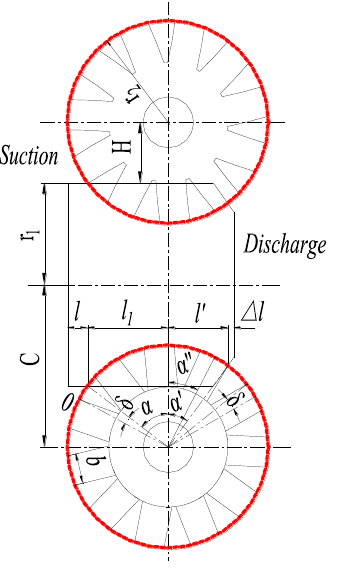
Figure 5. Geometric relationships of SSE.